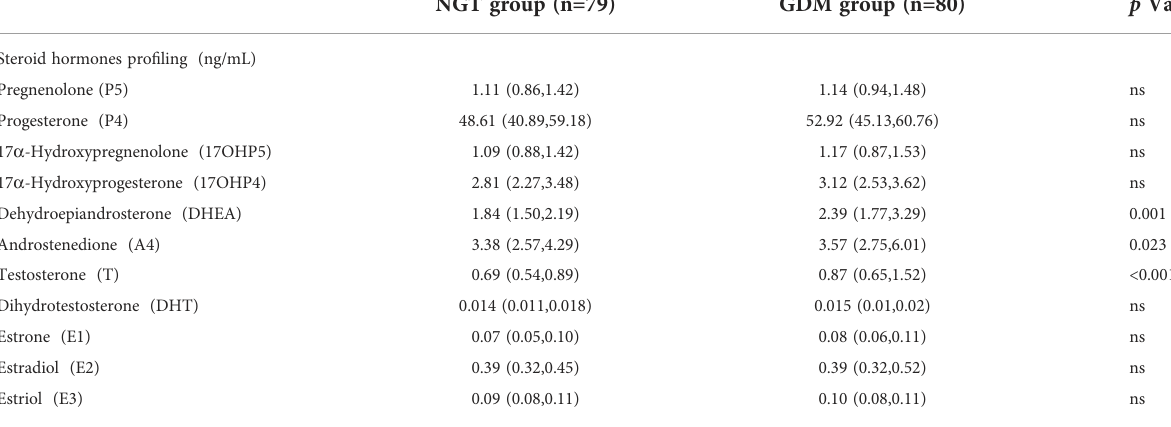
TABLE 2 The results of steroid hormones in women with GDM and women with NGT.